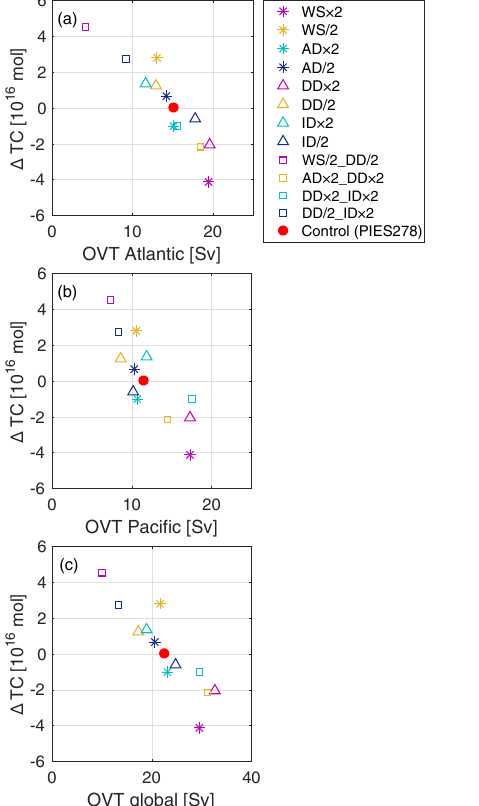
Figure 3. Strength of the overturning circulation in terms of OVT (see Sect. 3.4) and the change in TC inventory for equilibrium states SE1–SE12 relative to the control PIES278 (red dot). This is shown for the Atlantic basin, Pacific basin and for the global measure based on hemispheric differences on the horizontal axis of panels (a, b, c) respectively.